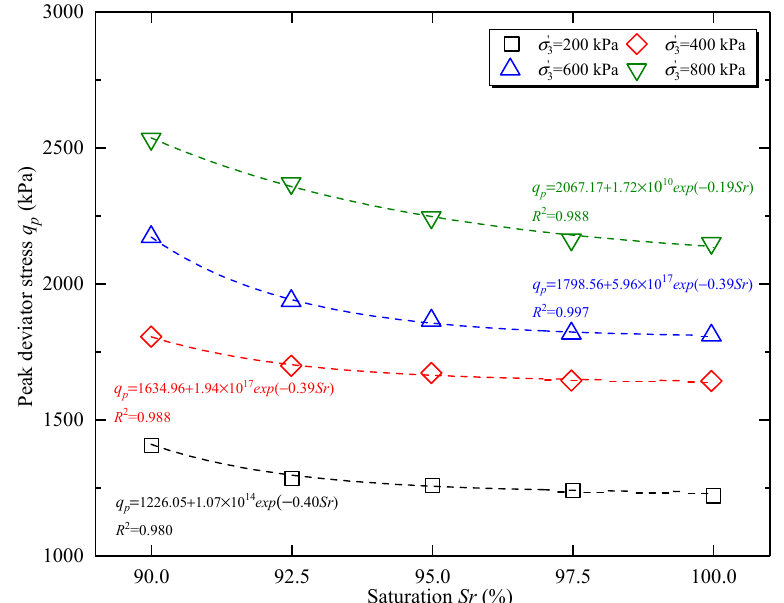
Figure 10. Relationship between peak deviator stress and saturation of coral sand. Table 6. Peak deviator stress–saturation fitting expression and parameters.